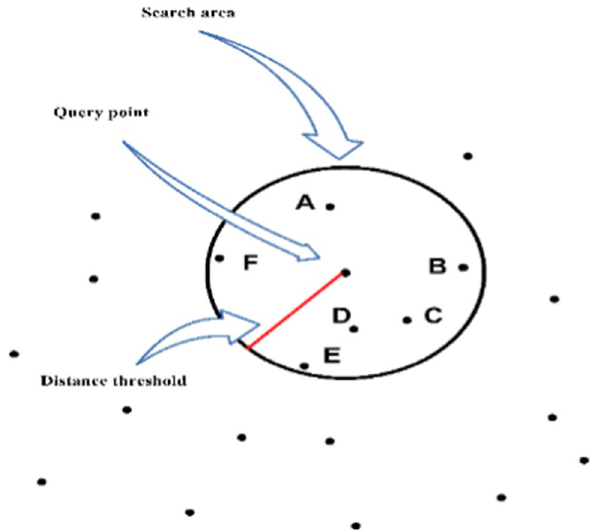
Fig. 3 Rang query operation over a virtual spatial input dataset